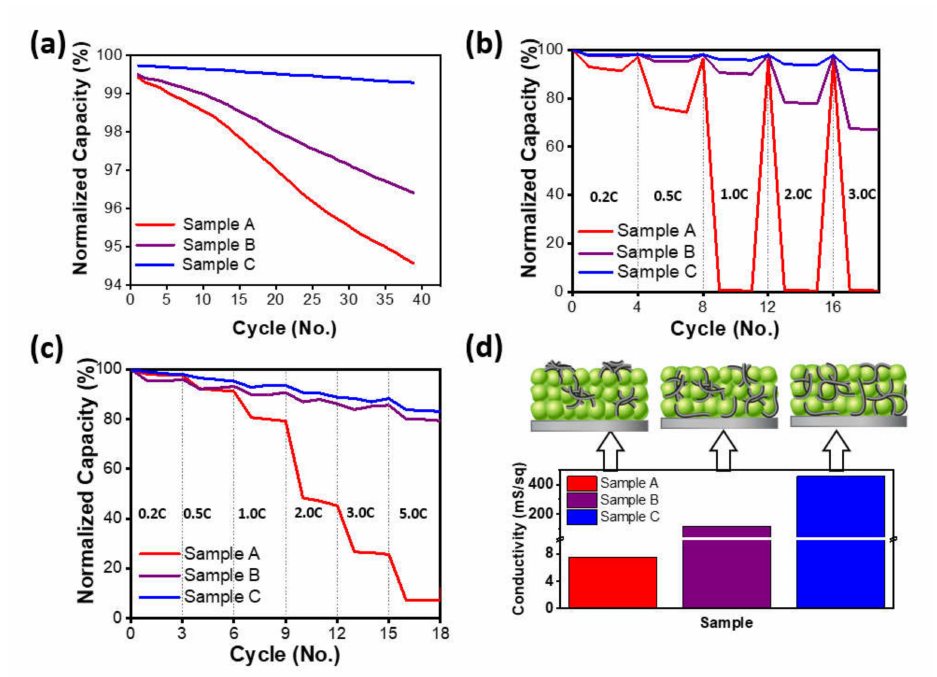
Figure 3. ( a ) Normalized reversible discharge capacity versus cycle graph of sample A, B, and C at 5.0 C. ( b ) Charge character graph of those samples under different charging C-rates from 0.2 C up to 3.0 C. ( c ) Discharge character graph of those samples under different discharging C-rates from 0.2 C up to 5.0 C. ( d ) Conductivity measurement graph of fabricated cathode electrodes including CNT samples by using a four-point probe resistance